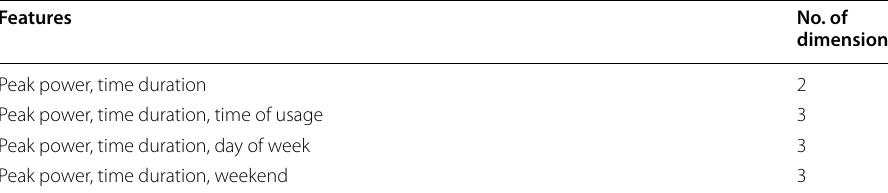
Table 3 Combination of features of the four clustering plans